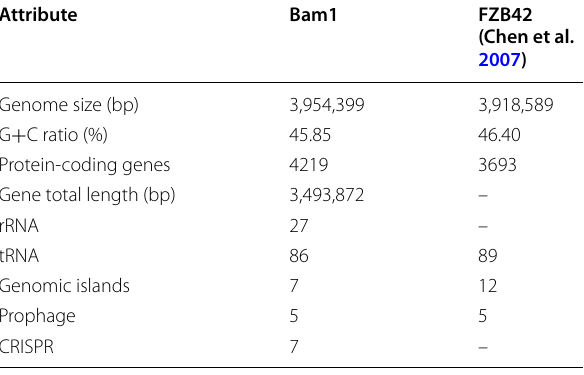
Table 1 Genomic features of the B. amyloliquefaciens strain Bam1 and B. velezensis strain FZB42